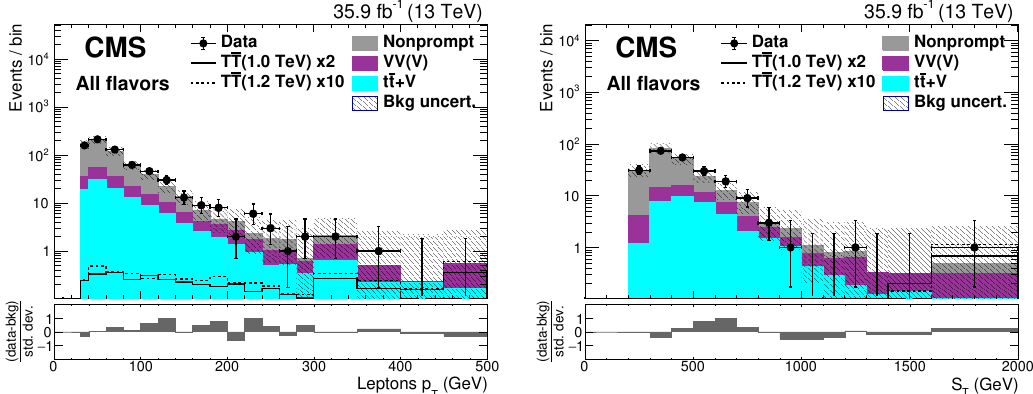
Figure 4 . Distributions of lepton p T (left) and S T (right) before the (cid:12)t to data in the control region of the trilepton channel. The black points are the data (horizontal bars indicate the bin width) and the (cid:12)lled histograms show the background distributions, with simulated backgrounds grouped into categories as described in section 3. The expected signal is shown by solid and dotted lines for T quark masses of 1.0 and 1.2 TeV. The (cid:12)nal bin includes over(cid:13)ow events. Uncertainties, indicated by the hatched area, include both statistical and systematic components. The lower panel shows the di(cid:11)erence between data and background divided by the total